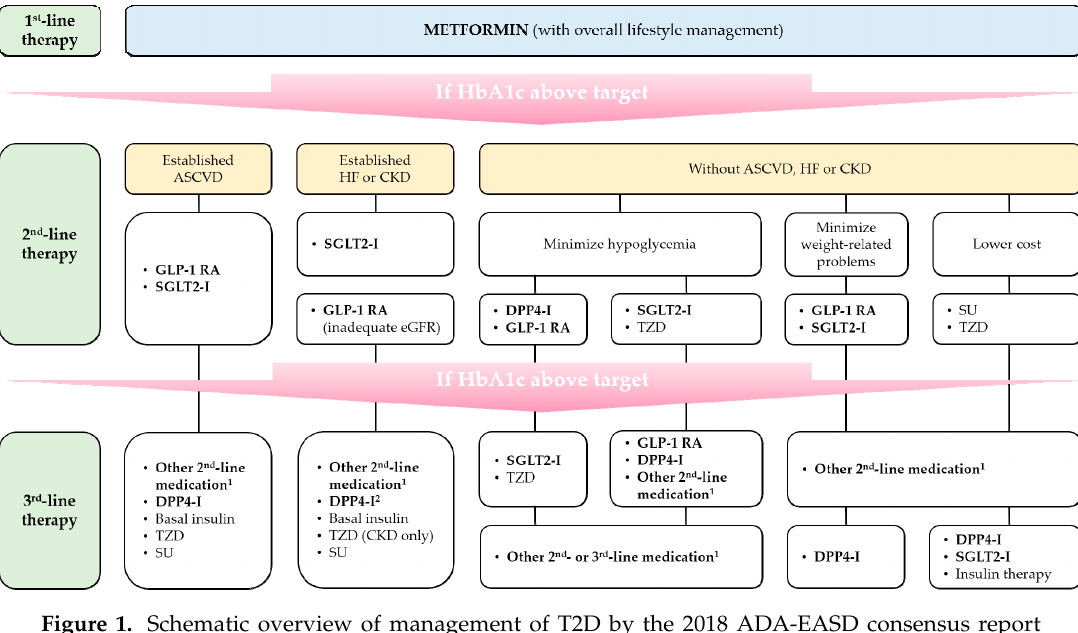
Figure 1. Schematic overview of management of T2D by the 2018 ADA-EASD consensus report (Adapted from Ref. [10], by permission of Springer Nature.). 1 drug classes not selected in previous step(s); 2 saxagliptin is excluded. ASCVD, atherosclerotic cardiovascular disease; CKD, chronic kidney disease; DPP4-I, DPP-4 inhibitor; eGFR, estimated glomerular filtration rate; GLP-1 RA, GLP-1 receptor agonist; HF, heart failure; HbA1c, glycated hemoglobin; SGLT2-I, SGLT2 inhibitor; SU, sulfonylurea; TZD, thiazolidinedione.